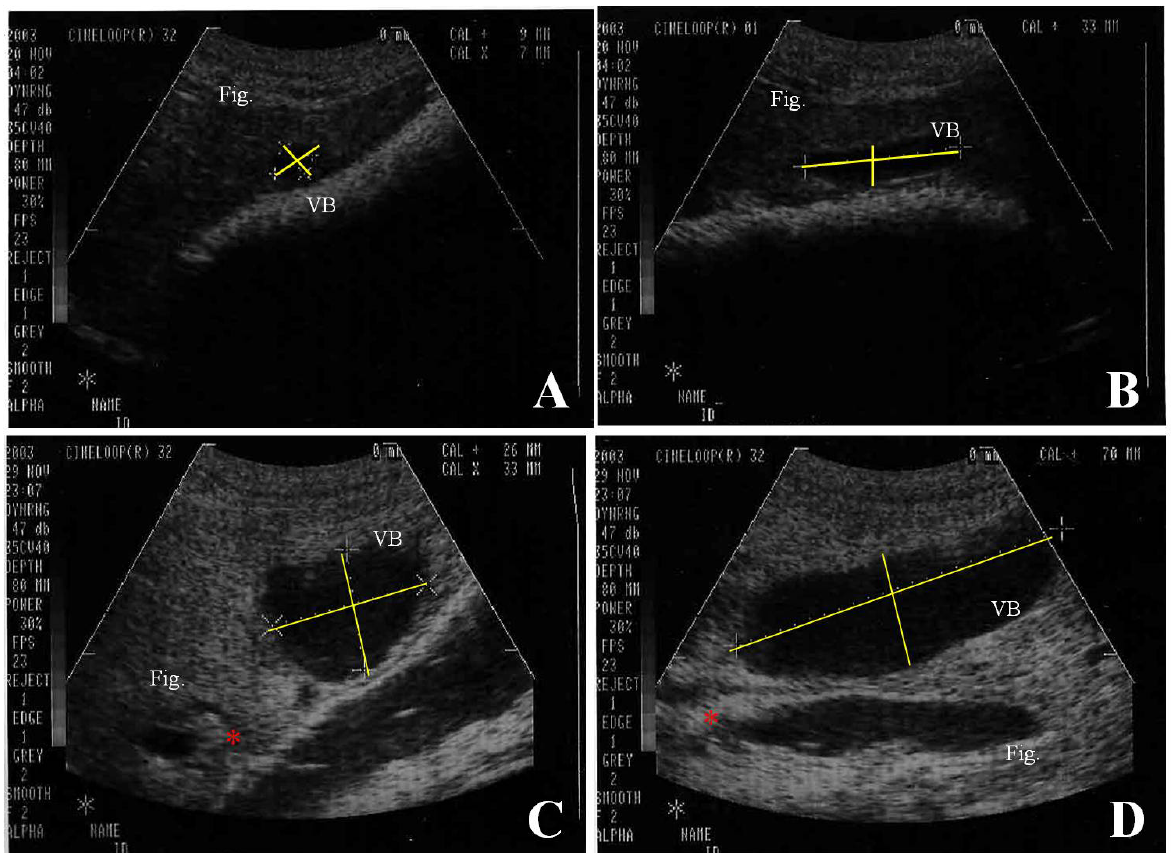
FIGURE 4 - Ultrasound images of gallbladder (lines) in swine subjected experimental biliary obstruction. A - transversal diameter pre-obstruction; B - longitudinal diameter pre-obstruction; C - transversal diameter post-obstruction; D - longitudinal diameter post-obstruction. Observe the increase in organ size (lines) when comparing A with C and B with D. Is observed, also, increased echogenicity of hepatic parenchyma in C and D (*). FAFRAM/FE -